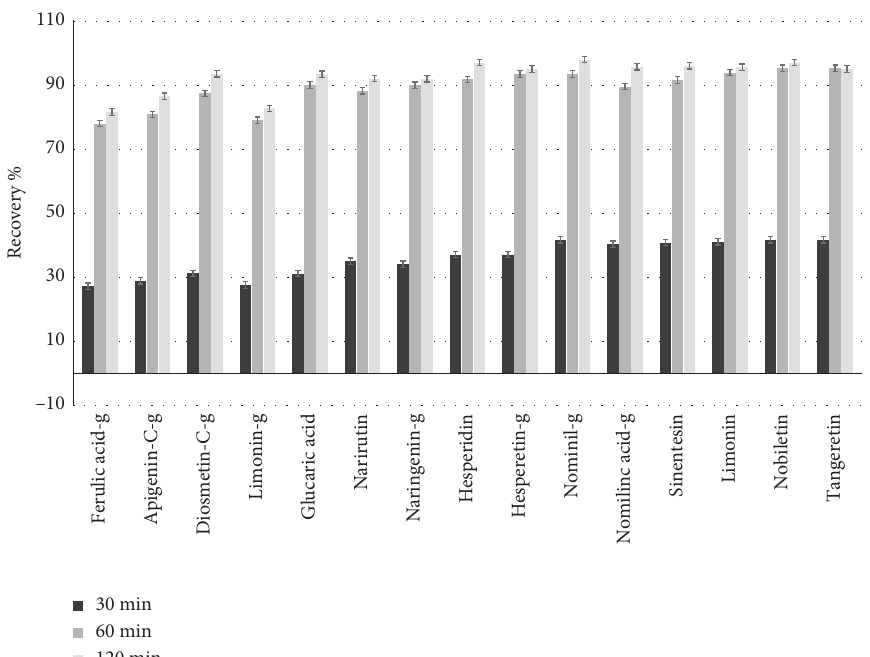
Figure 4: Recovery percentage of target analytes using different contact times of elution solvents and macroporous resin. Values are means of three replicates ± relative standard deviation (RDS%).